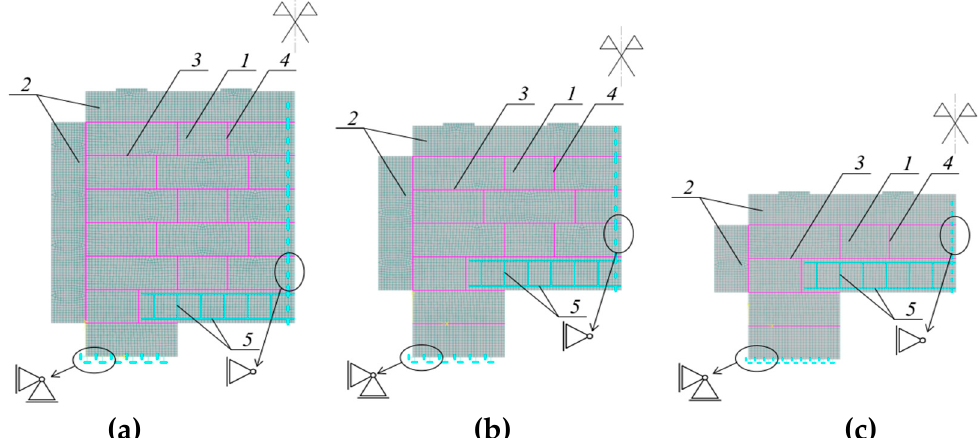
Figure 16. Numerical models of wall parts used in finite element method (FEM) calculations for the following series: ( a ) model of elements of the numeral model I (NI) series, ( b ) model of elements of the NII series, ( c ) model of elements of the NIII series: 1—masonry units with the elastic-plastic based M-W-3 model, 2—reinforced concrete elements with the brittle model, 3—contact elements in bed joints, 4—contact elements in head joints, 5—finite elements representing reinforcement with the Huber–Mises–Hencky (H-M-H) model.